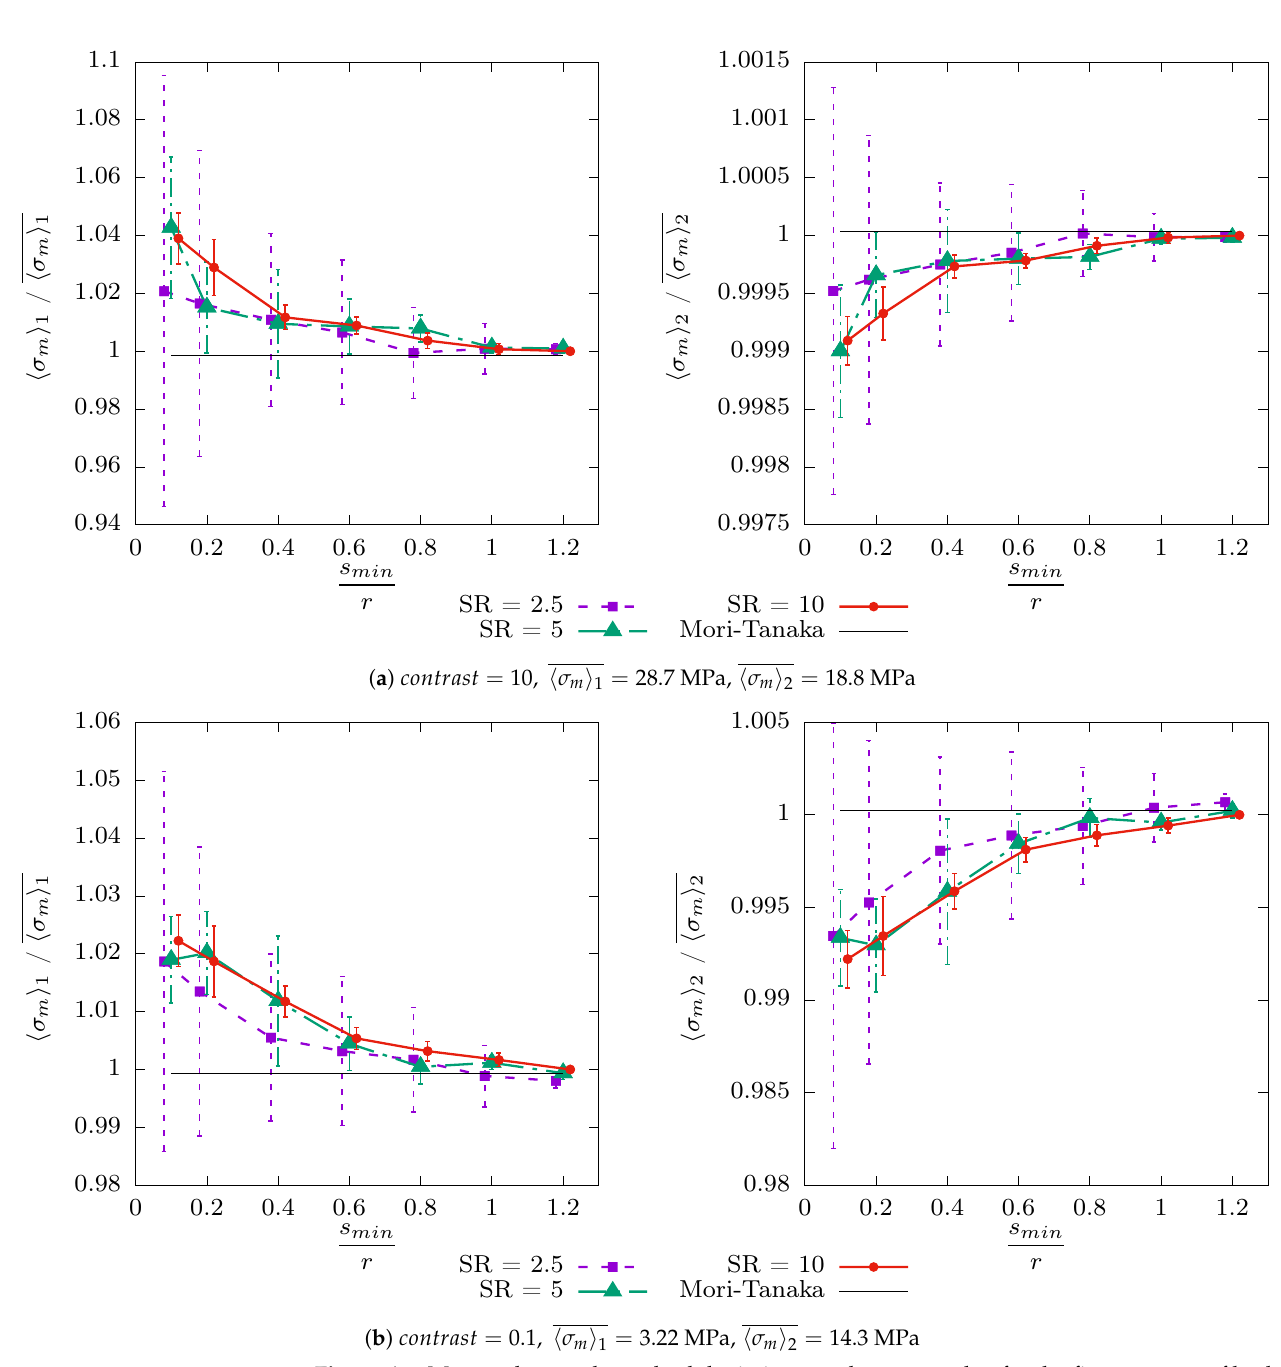
Figure A3. Mean values and standard deviations on the mean value for the first moment of hydro- static stress by phase as a function of the packing parameter s min / r ( r = 10 µ m) for a volume fraction of inclusions f v = 13.4 %. For clarity, the error bars and dots are slightly shifted around for each studied minimum